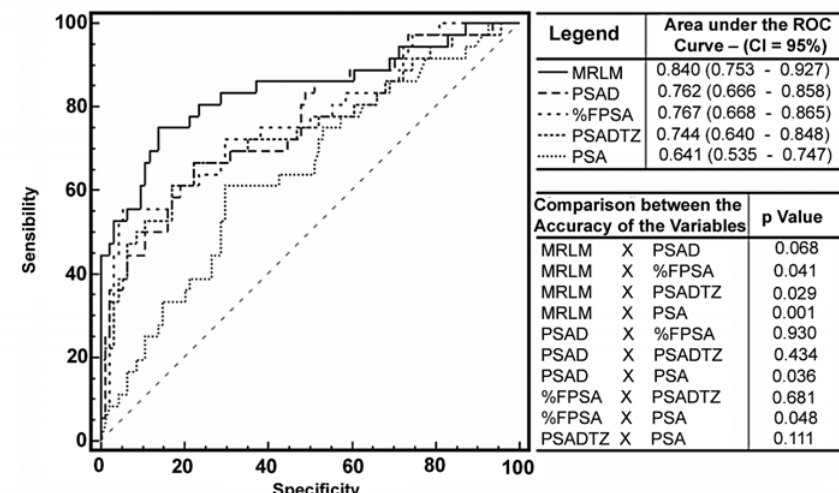
Figure 3 – Receiver Operating Characteristic (ROC) curve and comparison between the areas bellow the ROC curve (accuracy) produced by the multivariate logistic regression model (MLRM), PSA density (PSAD), percentage of the free PSA (%FPSA), PSA density in the transition zone (PSADTZ) and PSA.